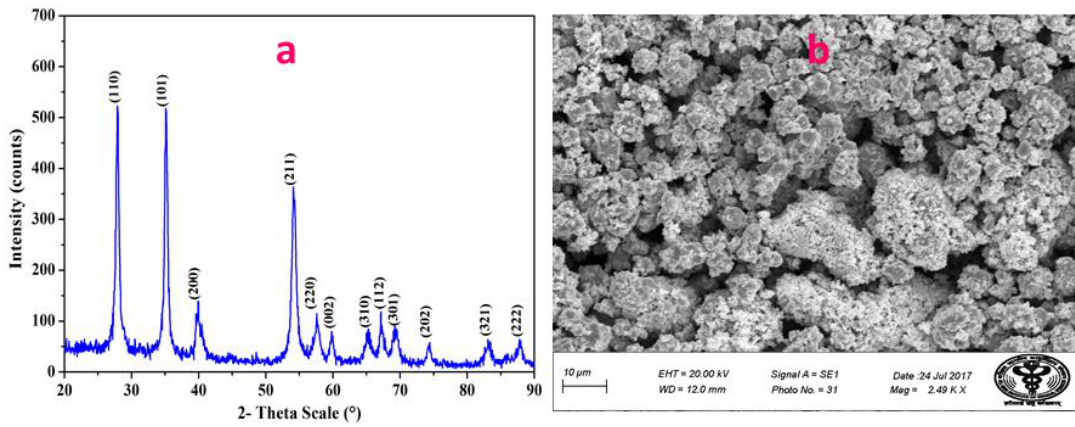
Figure 1. ( a ) X-ray diffraction pattern and ( b ) scanning electron microscope (SEM) micrograph of Ruthenium oxide nanoparticles.